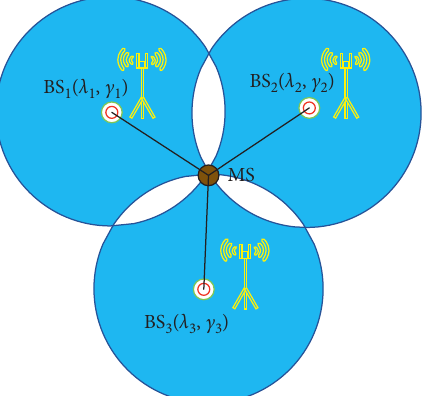
Figure 3: Positioning principle based on signal propagation